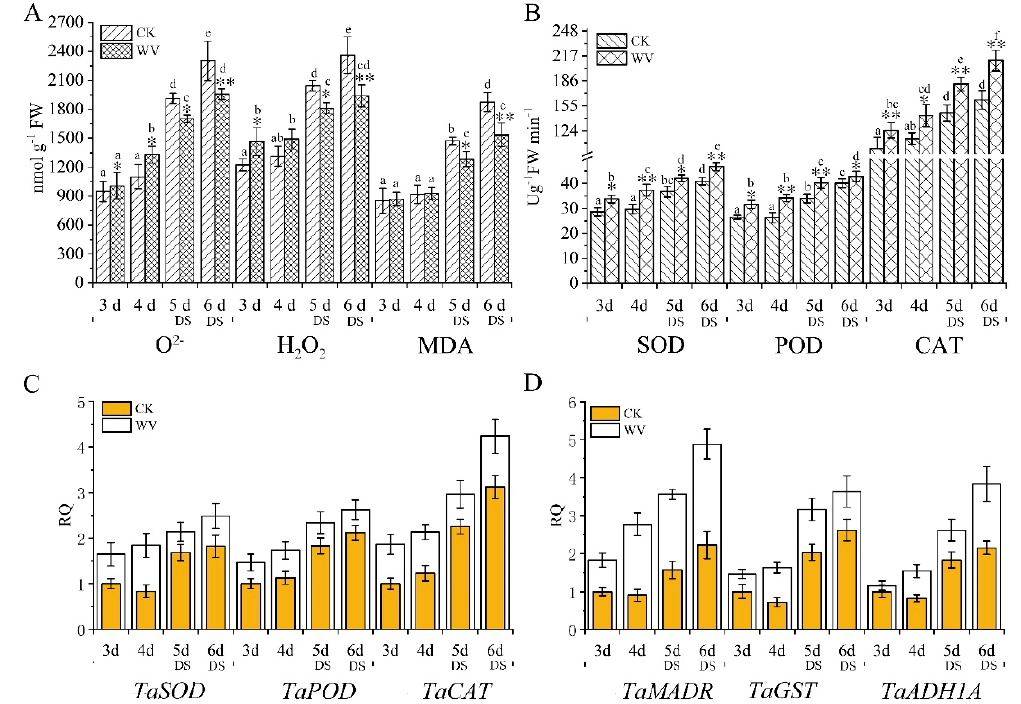
Figure 4. Assessment of ROS content, oxidative stress analysis, and expression pattern analysis of related antioxidative genes in wheat roots in both the control and WV treated groups before and after drought stress. The concentration of WV was 0 and 1:900 in the control and WV treated groups, respectively. The stages of non-drought stress and drought stress were from day 3 to day 4 and from day 5 to day 6, respectively, in both the control and WV treated groups. ( A ) The generation rate of O 2 − and content of H 2 O 2 in control wheat roots and WV treated roots; the content of malonaldehyde (MDA) in the control wheat roots and WV treated shoots. ( B ) The activity of superoxide dismutase (SOD), guaiacol peroxidase (POD), and catalase (CAT) in the control wheat roots and WV treated roots. ( C ) Expression pattern analysis of TaSOD , TaPOX1 , and TaAPX1 . ( D ) Expression pattern analysis of TaMDAR , TaGST , and TaADH1A . Data are means ± SD of three independent experiments (biological replicates). The significance of differences was assessed by Student’s t-test (* p < 0.05, ** p < 0.01). RQ, relative quantification.